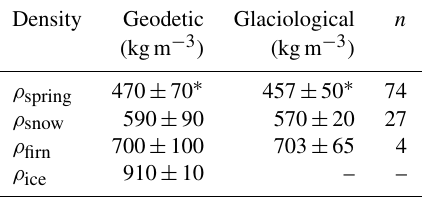
Table 4. Density values used for geodetic and glaciological balance. Glaciological values are average values. Density Geodetic